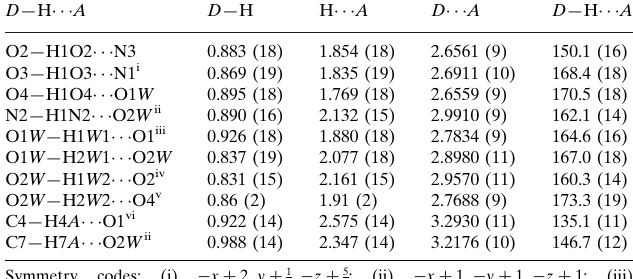
Data collection Bruker APEXII DUO CCD area- detector diffractometer Absorption correction: multi-scan ( SADABS ; Bruker, 2009) T min = 0.959, T max = 0.989 Refinement